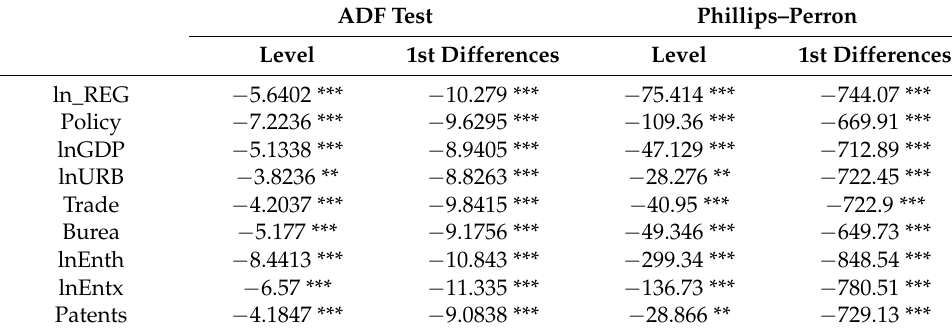
Table 4. Panel unit root